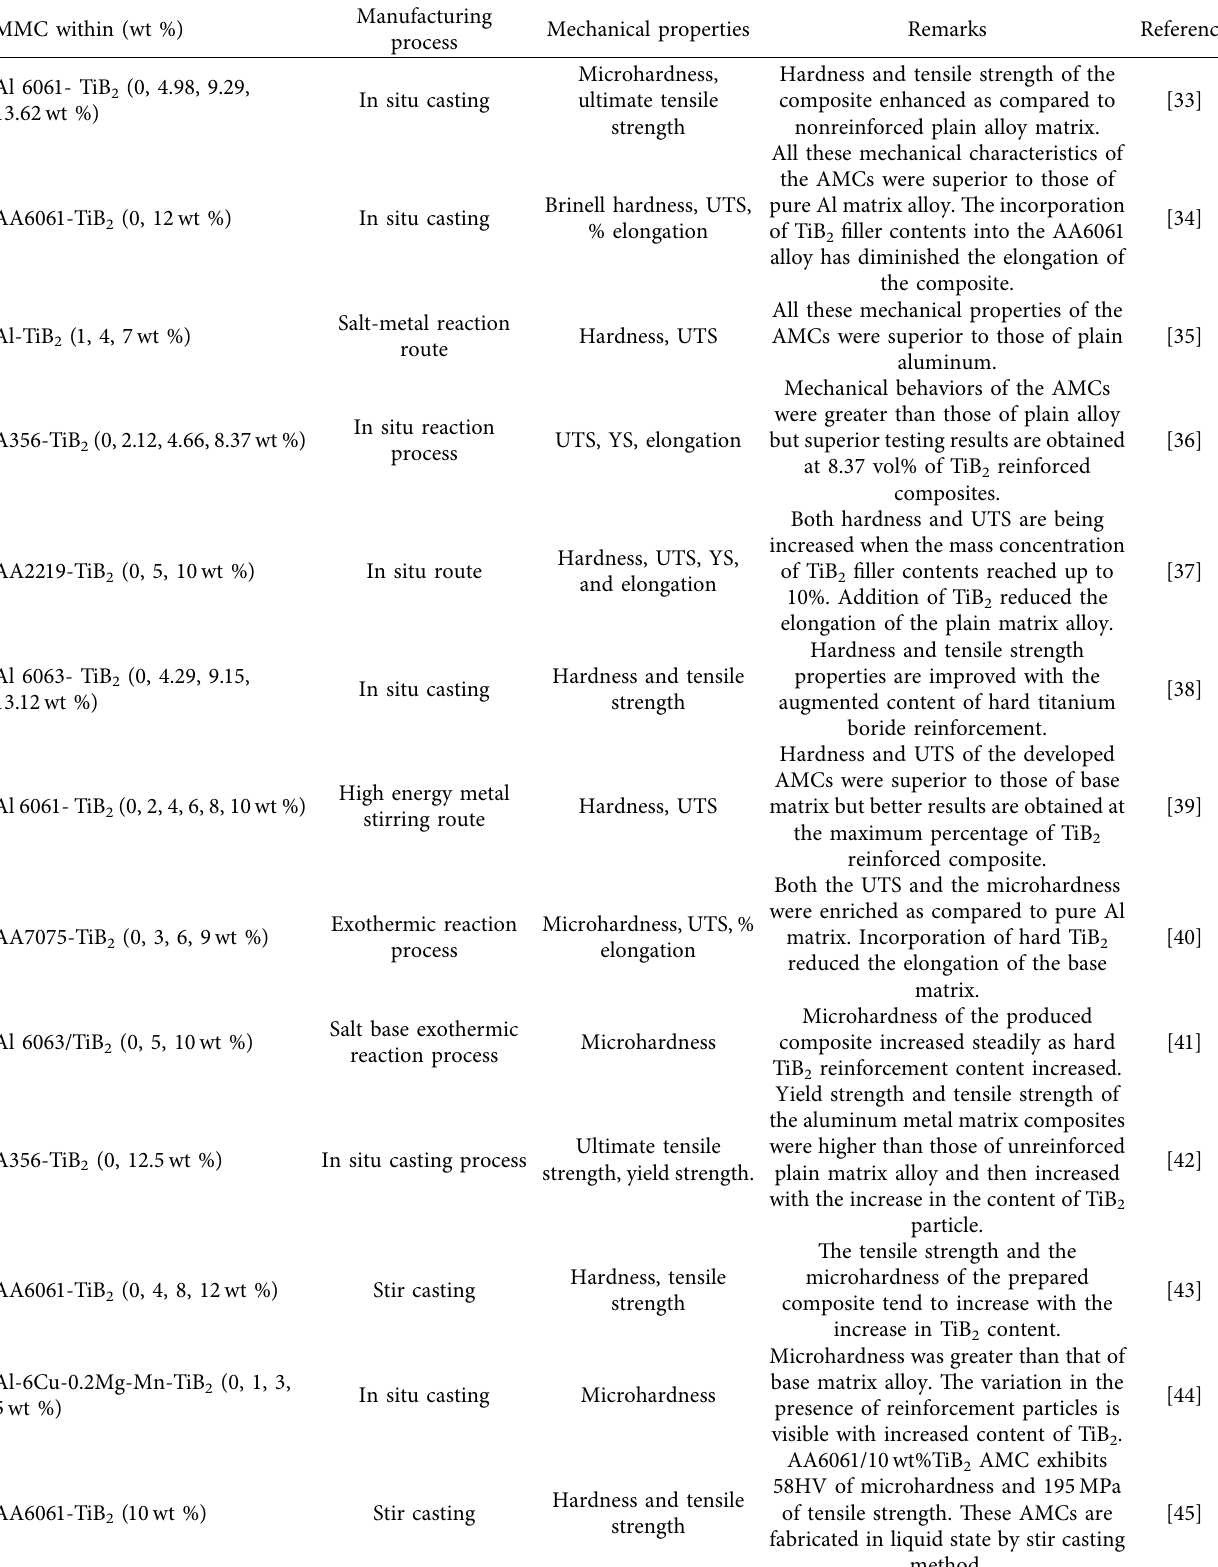
Table 2: Titanium diboride reinforced composites